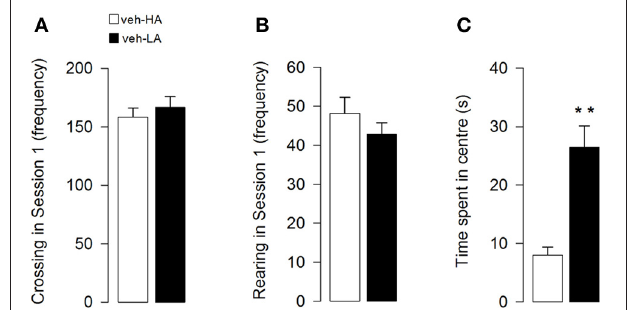
FIGURE 1 | Spatial Open-Field procedure. Schematic diagram representing the object configuration in the Spatial Open-Field test: (A) session 1, open field without objects; (B) session 2, habituation session with three stable objects; (C) sessions 3–4, spatial change discrimination sessions where object B displaced object A (session 4); (D) session 5–6, object novelty sessions where object D replaced object C (session 6).